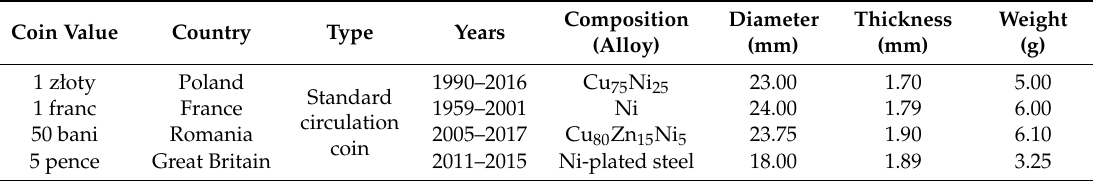
Table 3. Characteristics of the modern coins used in experimental